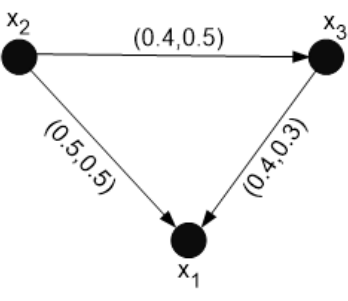
Figure 3. Example of an IFG.